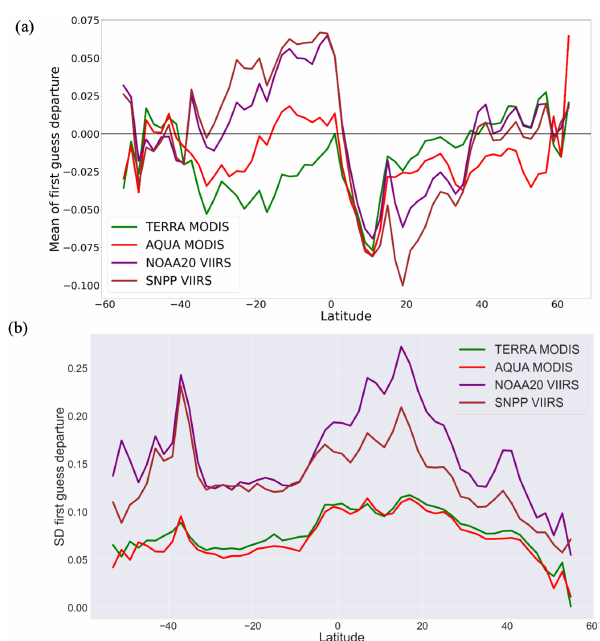
Figure 14. Latitude cross-section of the mean (a) and SD (b) of the first-guess departure for the DJF (2019–2020) period over